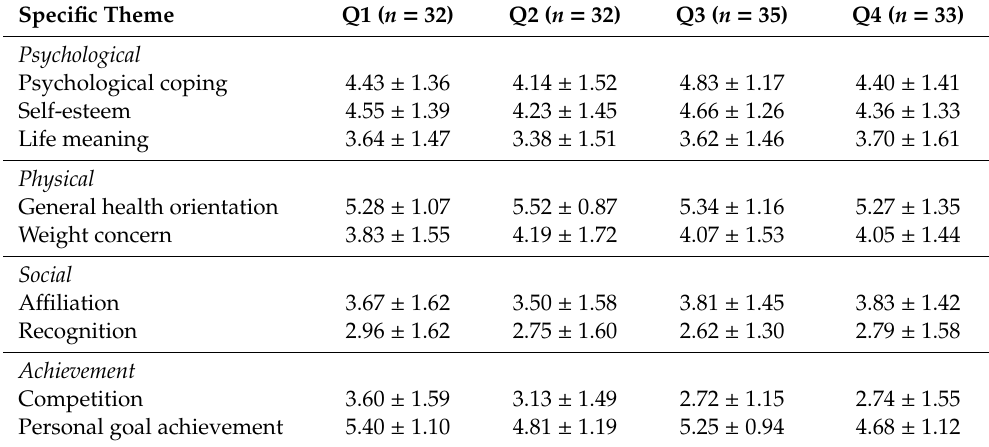
Table 2. The nine MOMS specific themes by performance group in male